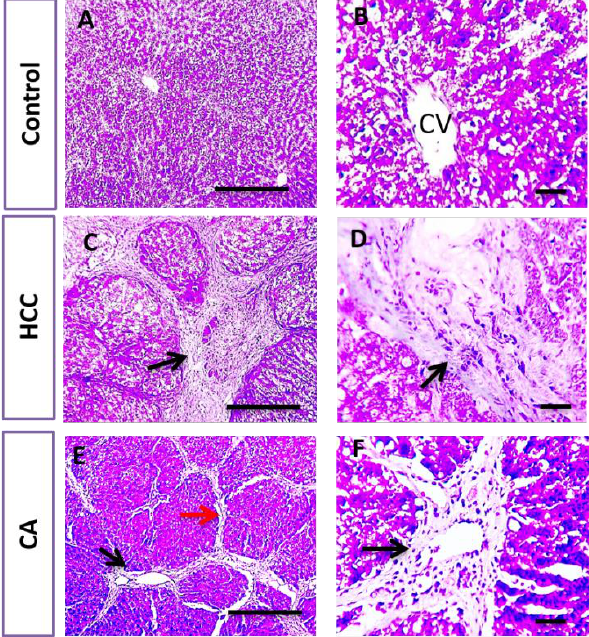
Figure 4. Histopathological examination of liver tissue in control, HCC and CA groups. Masson’s trichome stained liver sections. Microscopic pictures of hepatic sections from control group showing no collagen deposition. Meanwhile, hepatic sections from HCC group showed excessive bluish collagen deposition (black arrows) dividing hepatic lobules into separate nodules. Hepatic sections from CA group showed mild perivascular bluish collagen deposition (black arrows) with thin collagen strands extending from portal areas (red arrow). Ten rats in each group. Scale bar = 100 µm ( A , C , E ), Scale bar = 50 µm ( B , D , F ).